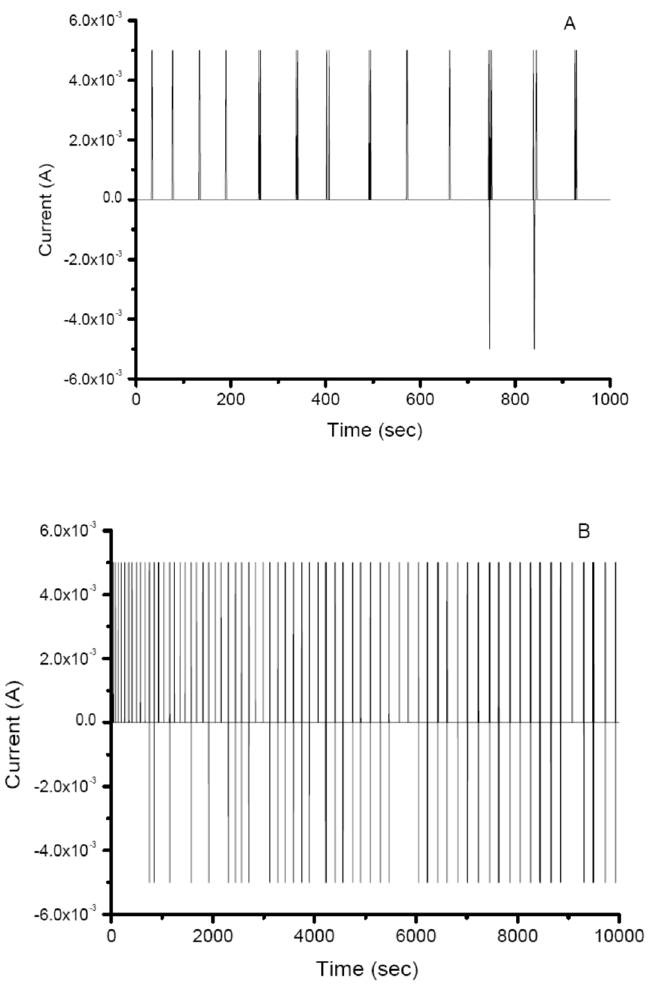
Figure 4. Output current variation of the MFC at the periods of 0−1000 s ( A ) and 0−10,000 s ( B